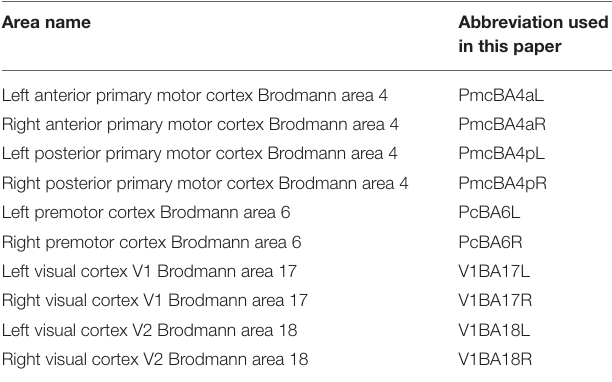
TABLE 2 | Area identified by univariate group subtraction as defined by Juelich histological